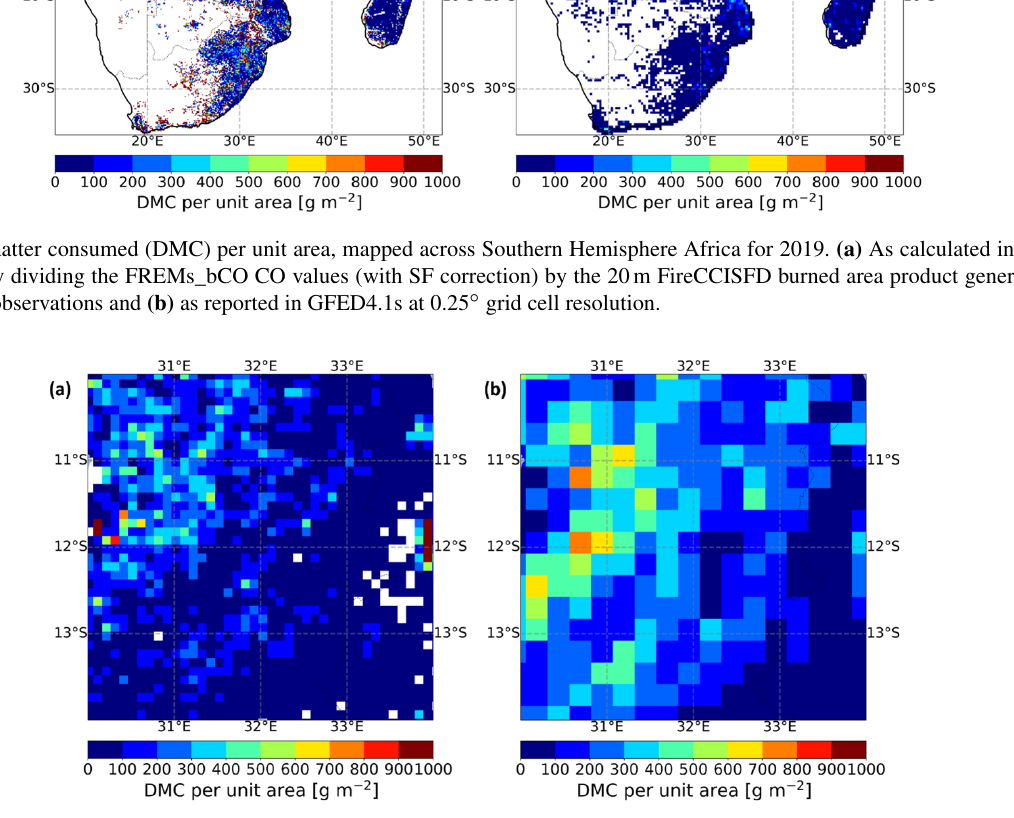
Figure 7. Mapped dry matter consumed (DMC) per unit area, calculated (a) at a 0.1 ◦ grid cell scale using the FREMs_bCO CO values (with SF correction) across a 4 ◦ × 4 ◦ region of Zambia for the year 2019 and (b) the same DMC per area values for